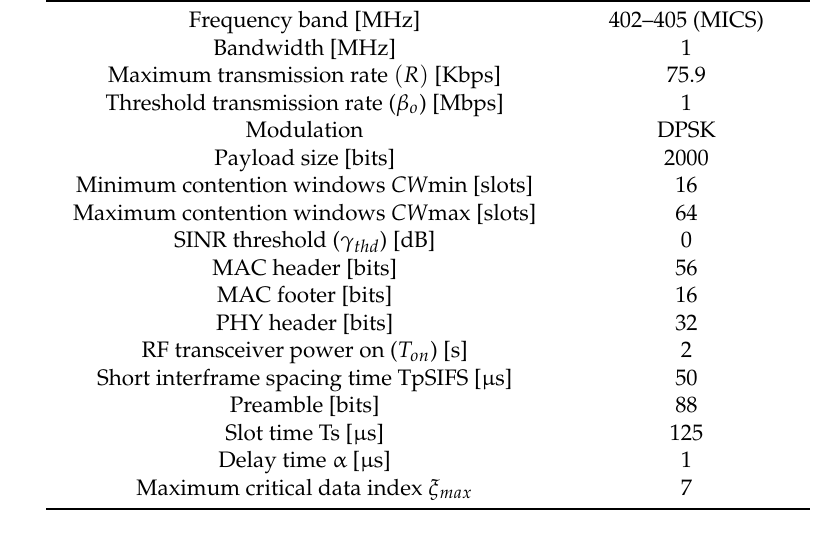
Algorithm 1: CD-ICC Pseudo